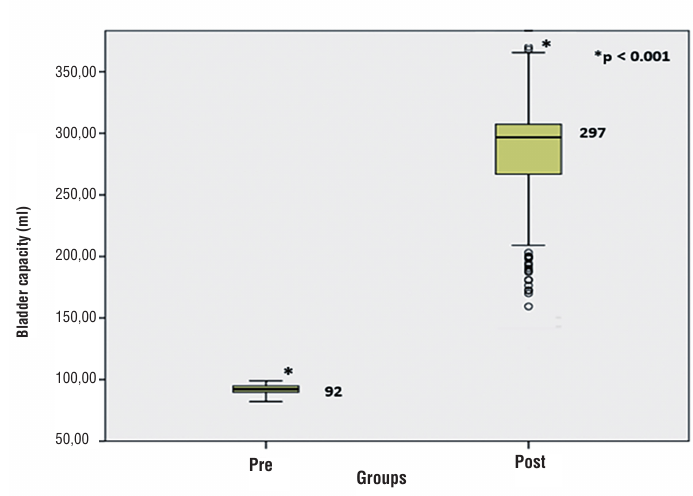
Figure 2 - Comparison of preoperative and postoperative bladder capacity.